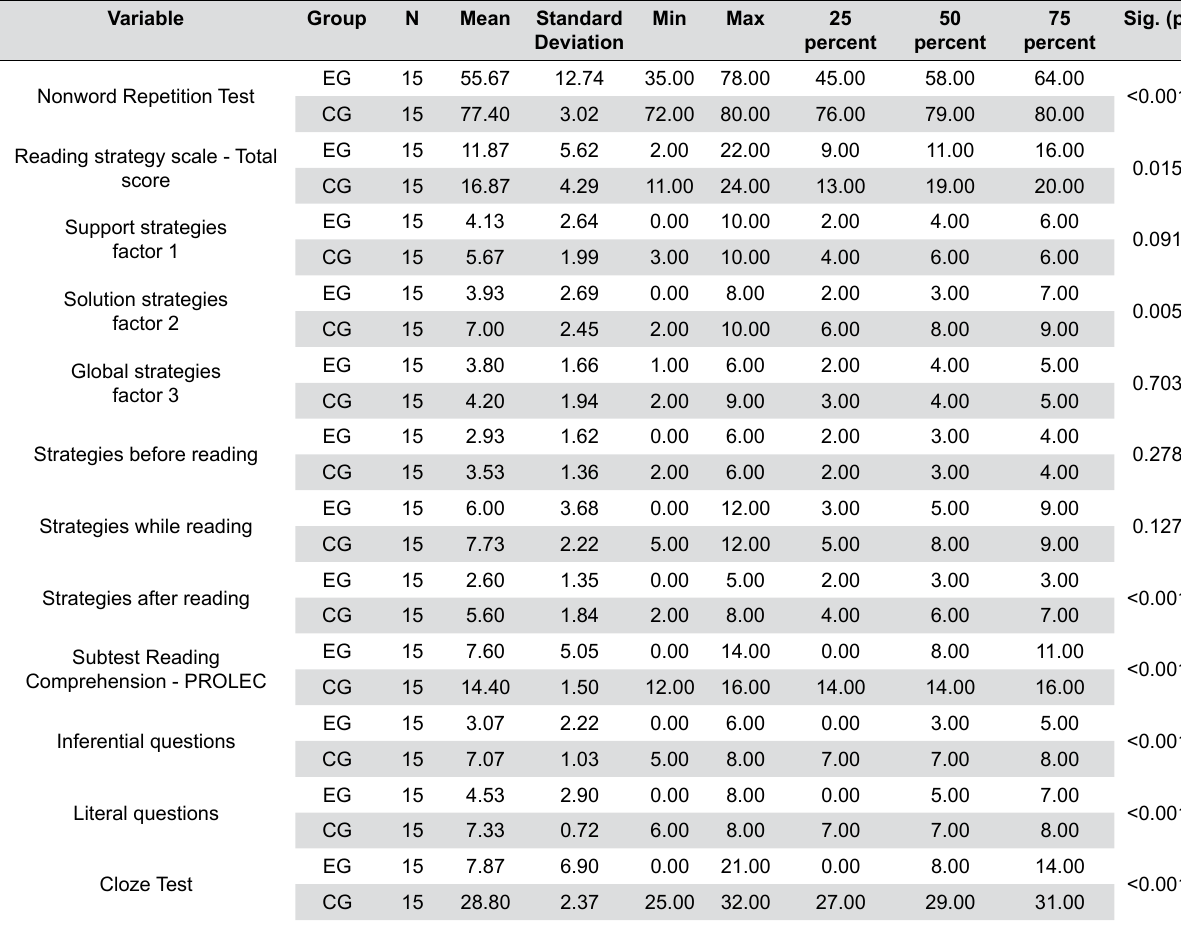
Table 1- Performance comparison between experimental and control groups in the